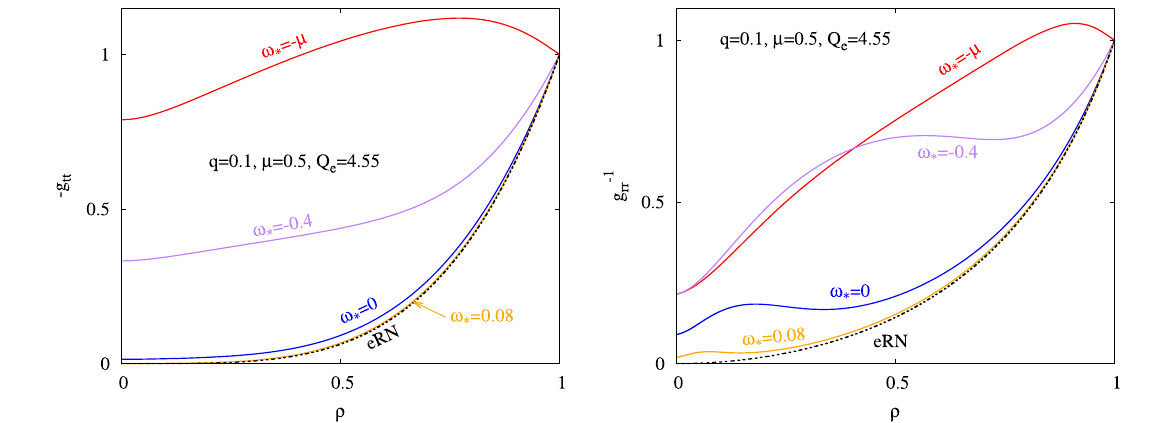
Fig. 1 Metric functions g tt (left) and g rr (right), versus the com- pactified coordinate ρ . Each color corresponds to a solution with w ∗ = {− μ, − 0 . 4 , 0 , 0 . 08 } (red, purple, blue and orange respectively),